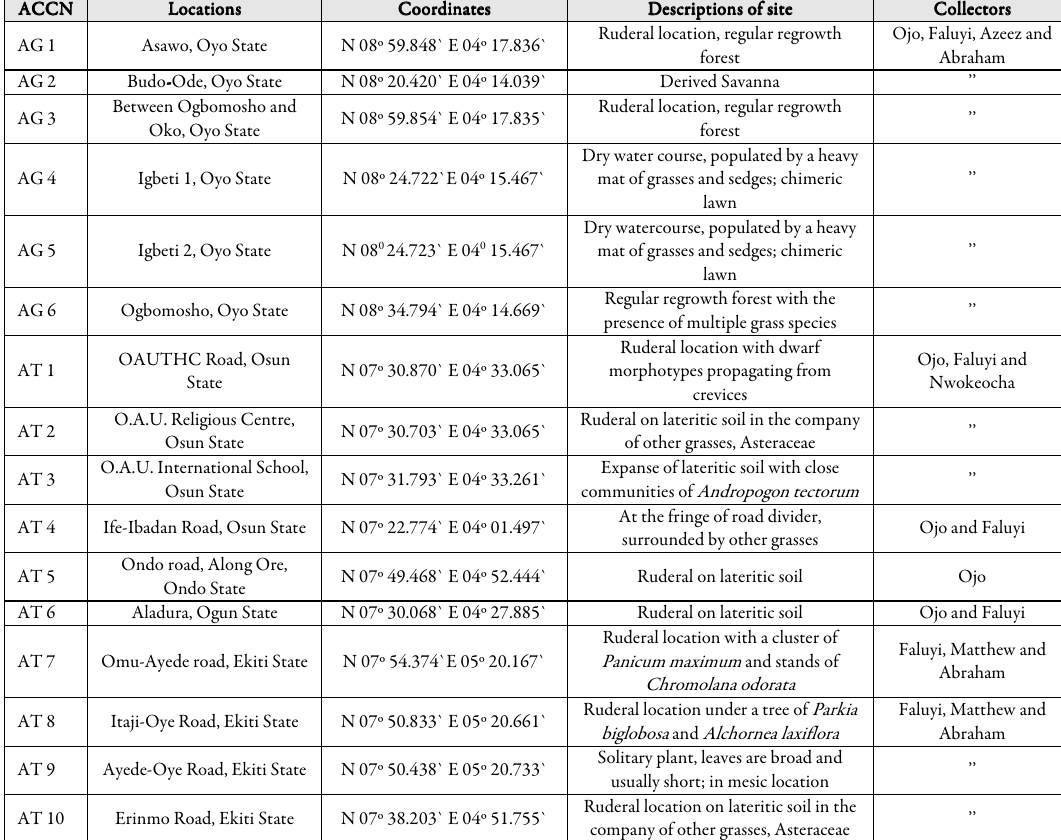
Table 1. Accessions of Andropogon gayanus (Kunth) - Andropogon tectorum (Schum & Thonns) studied and their